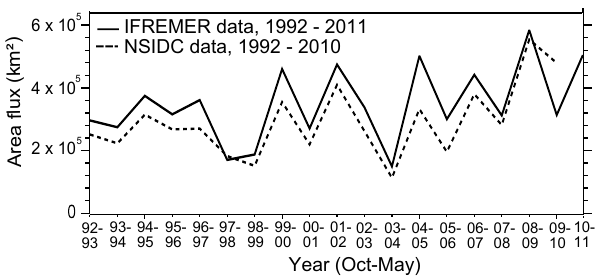
Fig. 3. Comparison between cumulative winter (October to May) Fig.3. Comparisonbetweencumulativewinter(OctobertoMay)IFREMER(solidline)andNSIDC(dashedline)totaliceareafluxestimates Ifremer (solid line) and NSIDC (dashed line) total ice area flux es- (given in 10 5 km 2 ) through the northern and eastern boundaries. timates (given in 10 5 km 2 ) through the northern and eastern bound-